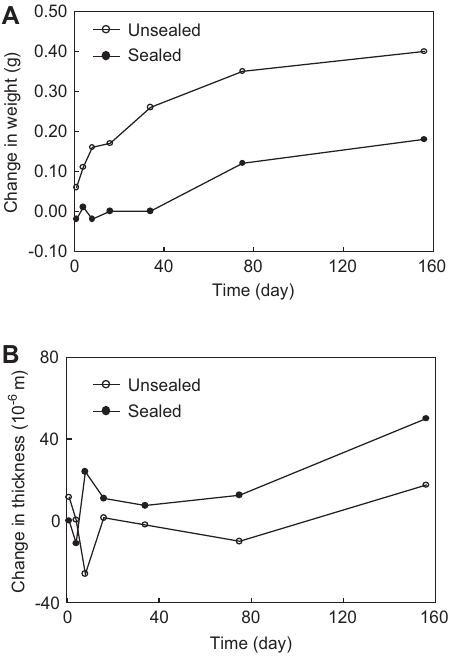
Figure 2 Changes in weight (A) and thickness (B) of the ZAZA coatings with